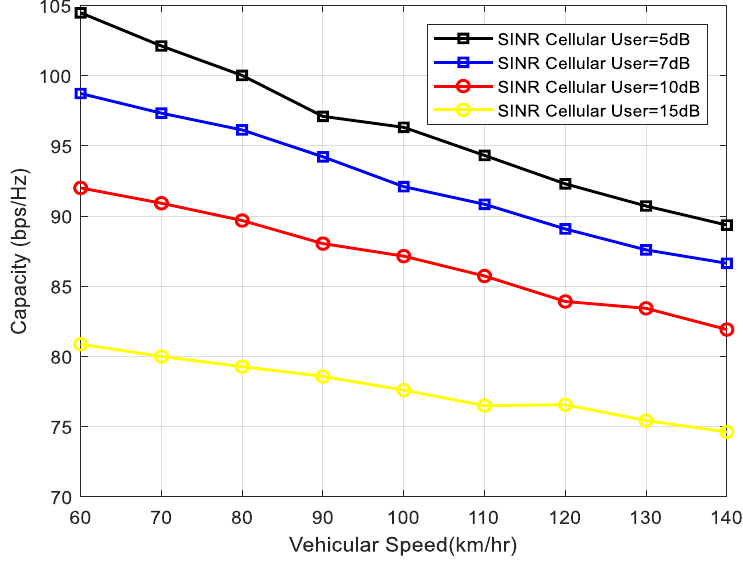
Figure 6. Vehicular speed vs capacity with different cellular user SINRs.